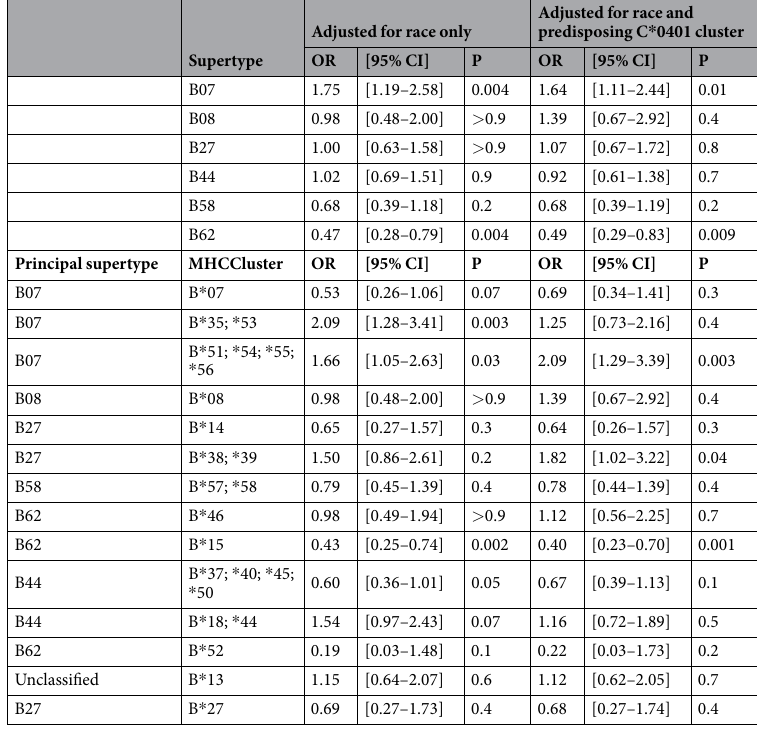
Table 1. HLA-B supertype and MHCcluster (2 digit) group associations with NVP HSR